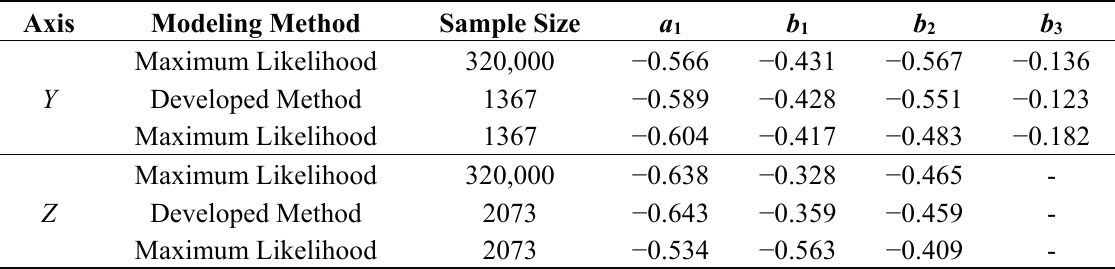
Table 2. Modeling result comparisons between different methods ( y , z -axis).